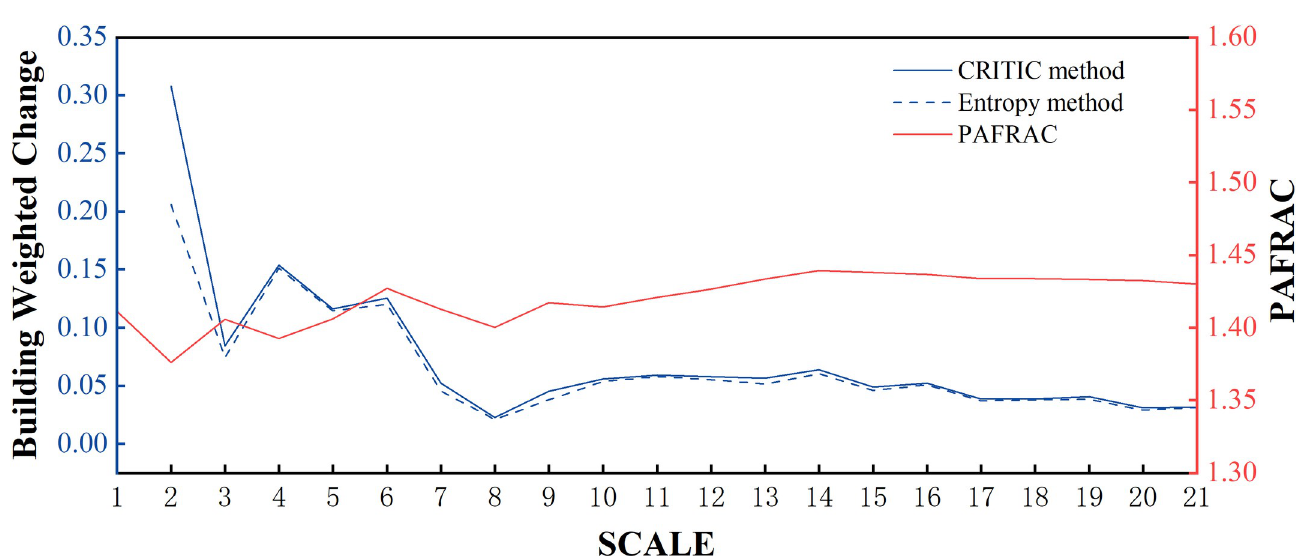
Fig 7. Scale-effect plots of weighted changes in landscape metrics and fractal dimension.